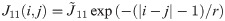
Long range spatial interactions can generate Turing-like patterns with an intrinsic length scale.(A) Spatial interaction strength of the first gene, J11(i,j)=J˜11exp(-(|i-j|-1)/r), as a function of distance |i − j| between lattice sites for different interaction ranges, r. (B) Schematic diagram of interactions in an extended model of patterning that permits long-range interactions. Interaction strength is indicated by the thickness of the arrows. Two genes in the model interact with a strong locally repressive interaction. The first gene has weak long range repressive spatial interactions; the second gene has strong nearest-neighbor positive interactions. (C) Patterns generated by the two genes for three different interaction ranges, r. The expression state of the first gene is pinned to ON at the anterior boundary by a strong morphogen signal, which is zero anywhere else. The length scale of the resulting pattern depends on the interaction range, r, of the first gene.